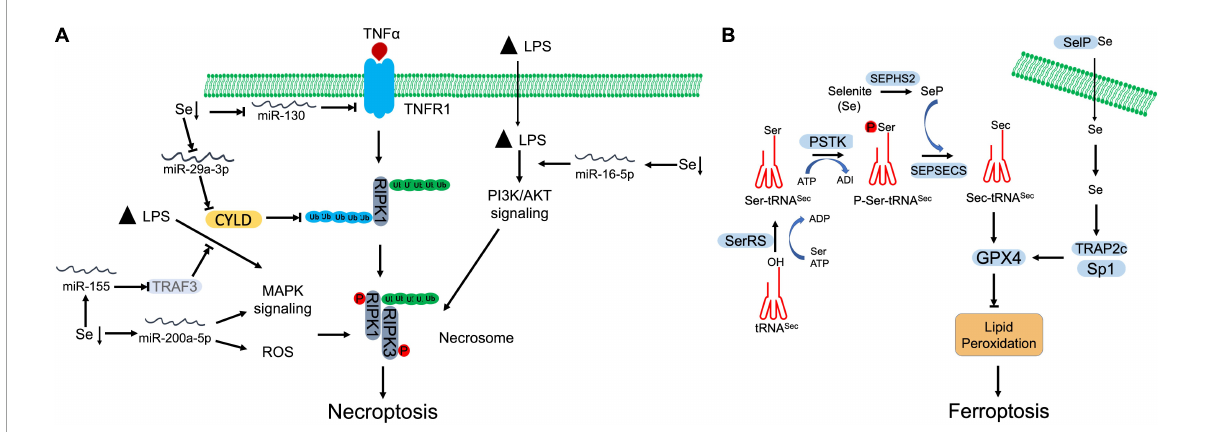
FIGURE2 Selenium (Se) antagnized regulated necrosis. (A) Necroptosis. Se deficiency promotes necroptosis by manipulating microRNAs, which target specific proteins involving in necroptosis signaling, MAPK signaling, and PI3K/AKT signaling. (B) Ferroptosis. To begin the synthesis of selenocysteine (Sec), seryl-tRNA synthetase (SerRS) attaches serine (Ser) to tRNA Sec . Then, Ser-tRNA Sec is phosphorylated by O -phosphoseryl-tRNASec kinase (PSTK) at seryl group to generate phosphoseryl—tRNASec (P-Ser-tRNA Sec ). Finally, Sep( O -phosphoserine) tRNA:Sec [selenocysteine] tRNA synthase (SEPSECS) converts P-Ser-tRNA Sec into selenocysteinyl (Sec)-tRNA Sec with the participation of selenophosphate (SeP), which is the main Se donor in the process, produced by selenophosphate synthetase 2 (SEPHS2). Synthesized Sec